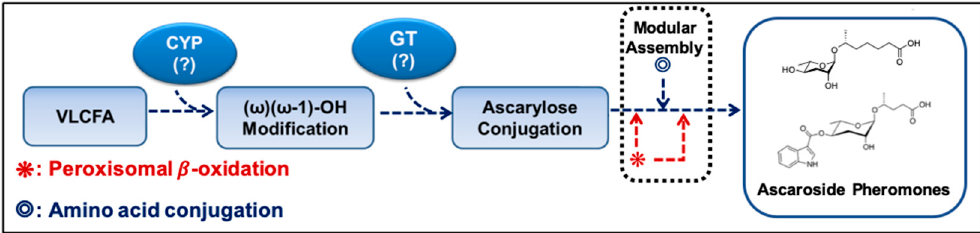
Figure 3. Schematic working model of the ascr pheromone biosynthetic pathway. CYP alters the very long chain fatty acid (VLCFA) produced via elongation of C16 or C18 fatty acids to produce ω -1 or ω -oxygenated VLCFA substrates. Ascarylose is then linked to the ω -1- or ω -oxygenated VLCFAs to form VLCFA-linked ascarosides. Finally, an ascr pheromone containing a shortened fatty acid chain is produced via peroxisomal β -oxidation. In this case, amino acid precursors are linked to specific ascr pheromones. CYP: cytochrome P450, GT: glucuronyltransferase. (?): Names of these enzymes are not known in C. elegans